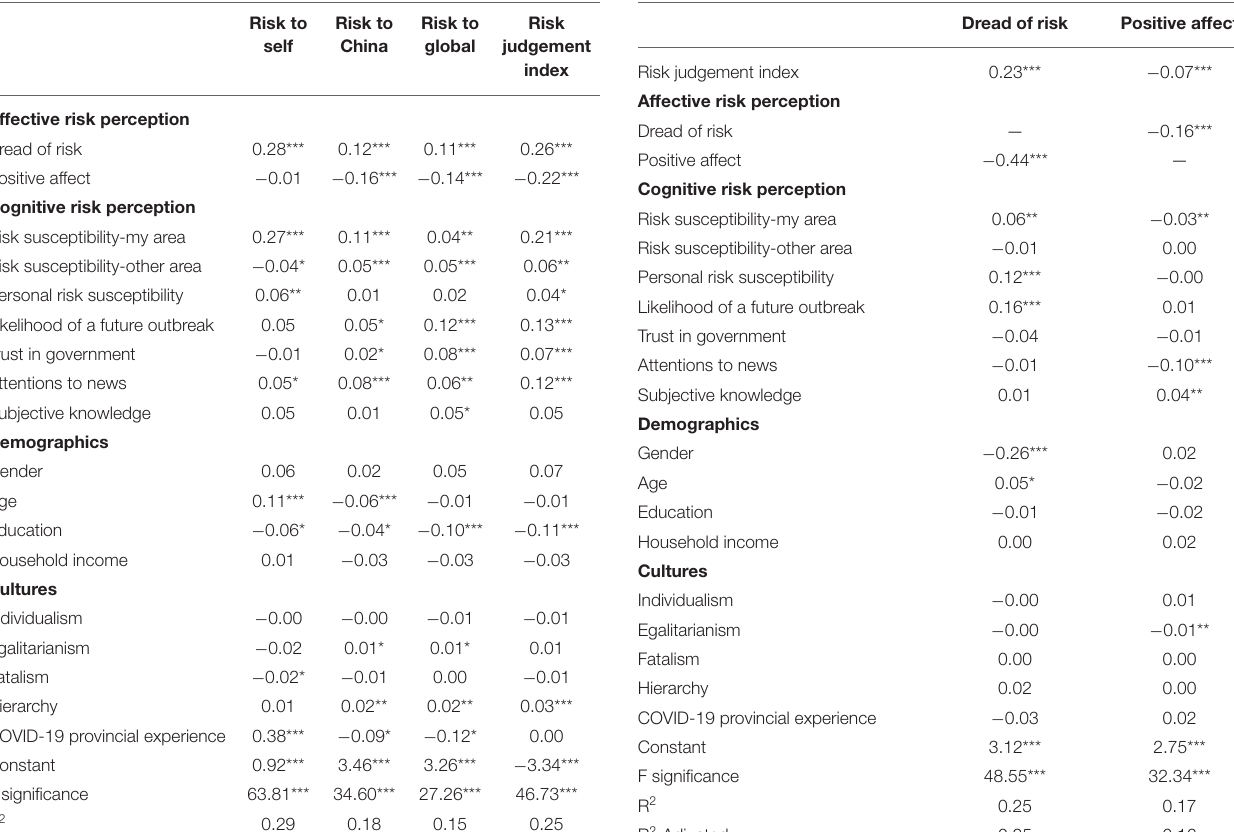
TABLE 3 | Linear regressions of affective risk perception and survey of public reactions to COVID-19, China,